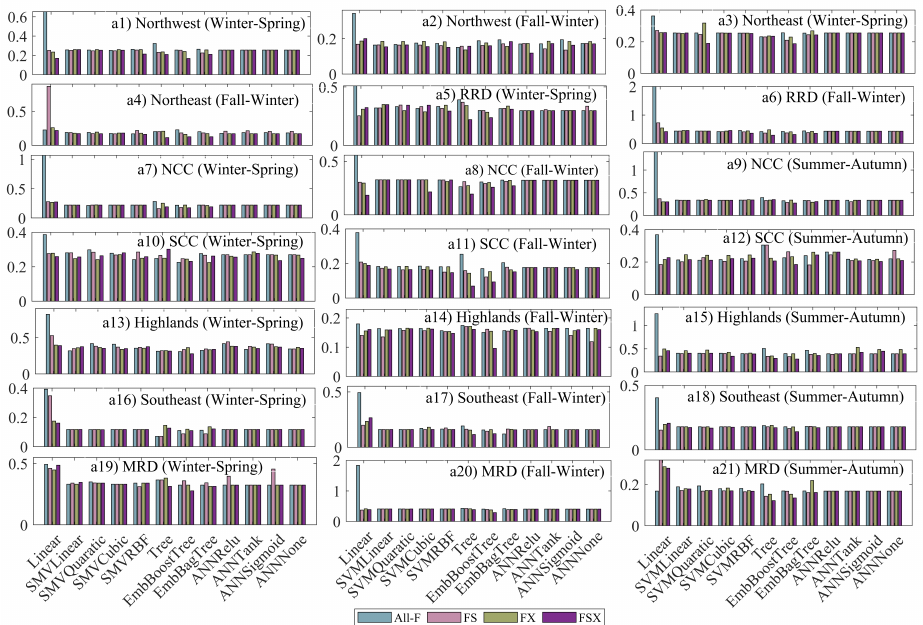
Figure 3. The RMSE of All-F-, FS-, FX-, and FSX-based models in different ML algorithms, units are